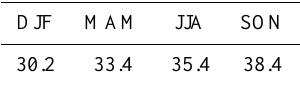
Table 2. Seasonal mean LNB ozone values (in ppbv) at American Samoa (for the period